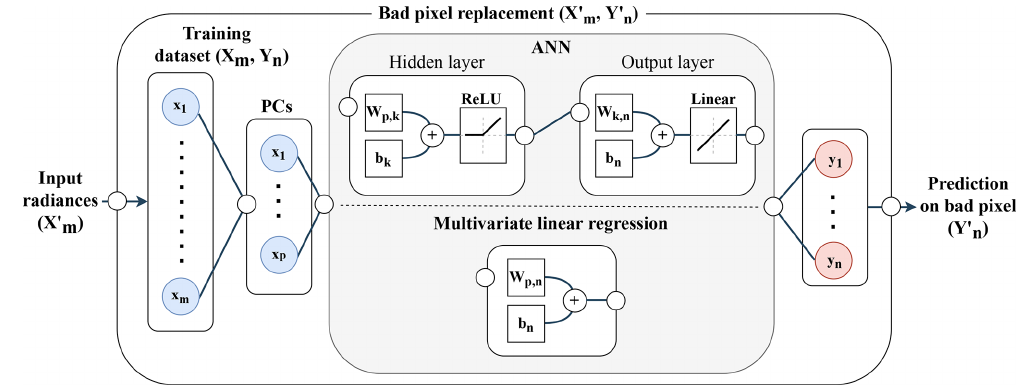
Figure 3. Schematic chart of the training and bad-pixel replacement process. W and b represent weight and bias parameters in each layer. The subscripts m , n , p and k are equal to the spectral dimension of input and output parameters, the number of PCs, and the hidden nodes of the ANN model, respectively. Table 2. Input and output (I/O) parameters for the training process of machine learning models and the optimized hyperparameter setting of the ANN